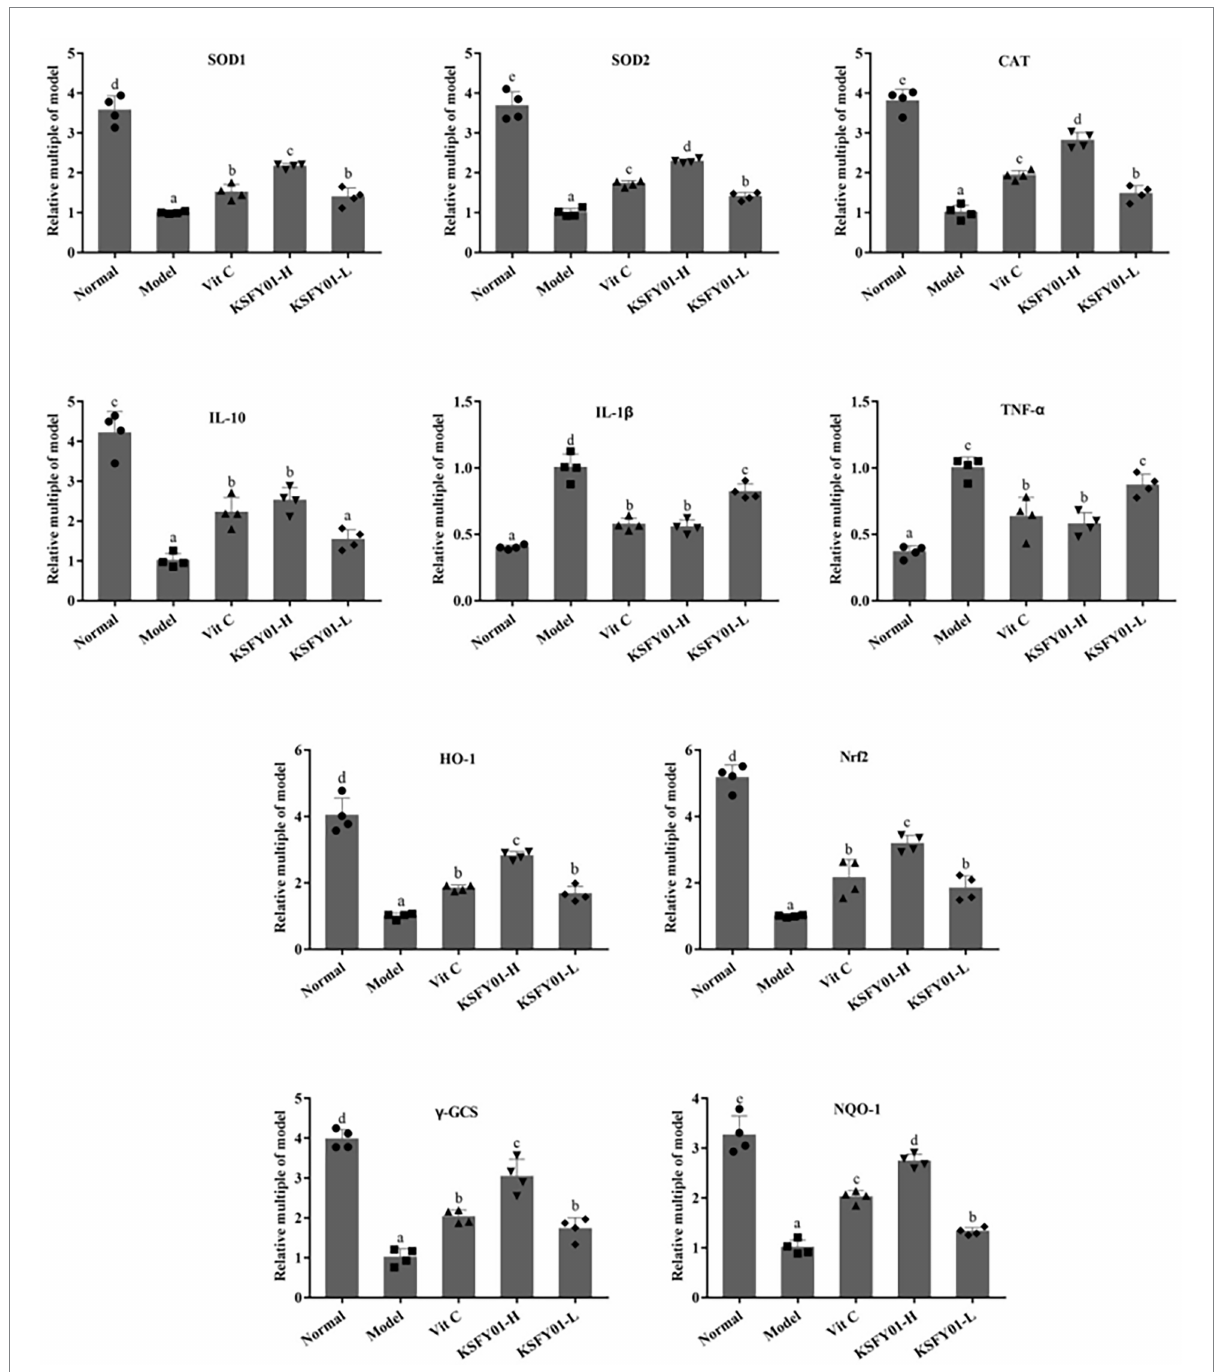
FIGURE 6 The SOD1, SOD2, CAT, IL-1 β , IL-10, TNF- α , HO-1, Nrf2, γ -GCS, and NQO-1 mRNA expressions in mouse skeletal muscle tissue. a–e Values in the same column with different letter superscripts indicate significant difference ( p < 0.05). Vit C, mice treated with vitamin C (200 mg/kg); KSFY01-H, mice treated with L. plantarum KSFY01 (1 × 10 10 CFU/kg); KSFY01-L, mice treated with L. plantarum KSFY01 (1 × 10 9